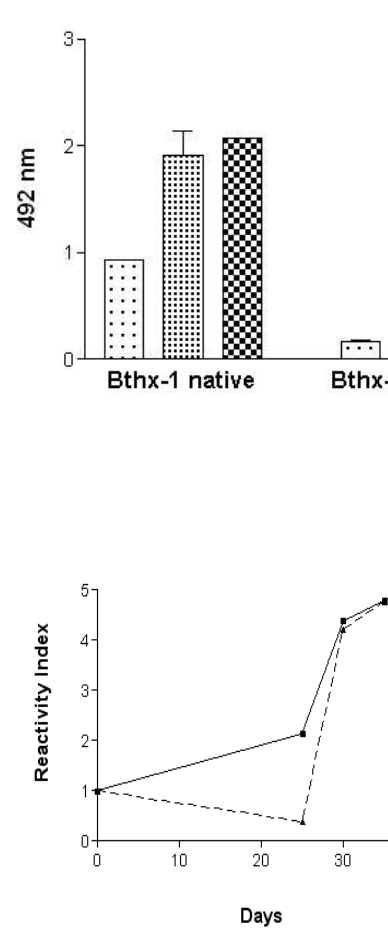
Figure 2. ELISA for detection of antibodies against native (Nat) and irradiated (Irr) bothropstoxin-1 samples ( A ). Plasma dilution: 1/800. Reactivity index of ELISA ( B